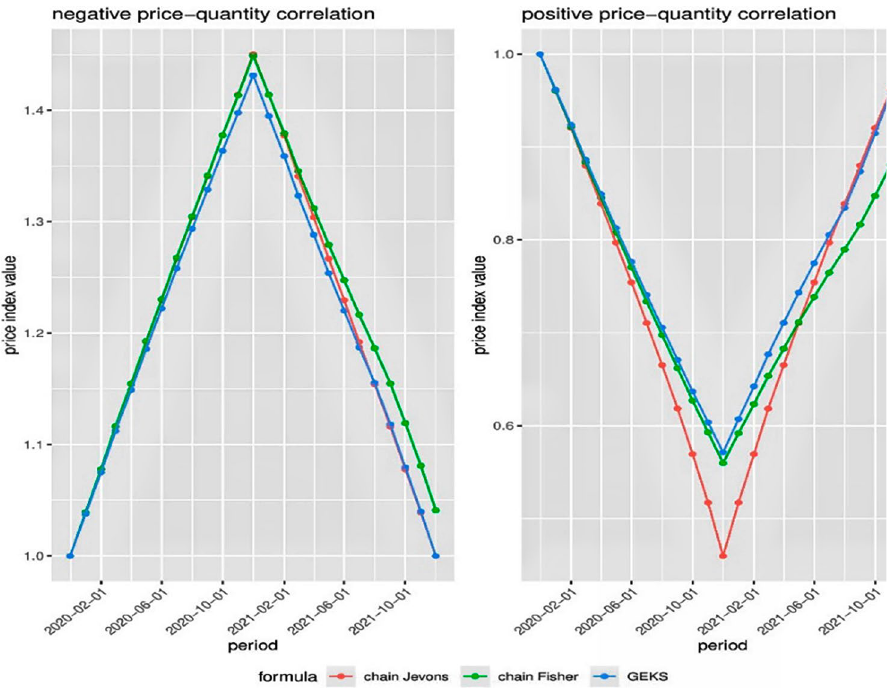
Figure 3. Comparison of selected chain indices to the GEKS method for Cases 1 and 2 and for d = 8 Table 1. Mean absolute distances between considered chain indices and the target GEKS price index (p.p): Case 1 Index: d = 0